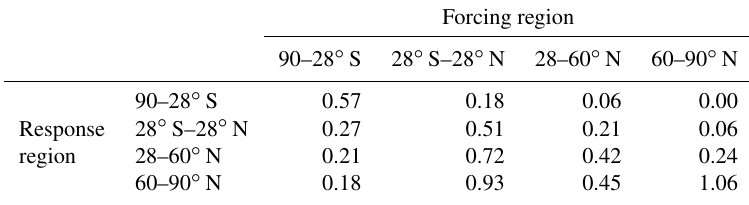
Table B2. Regional climate sensitivity coefficients employed in Eq. (B1) for radiative forcing due to BC in snow (K(Wm − 2 ) − 1 ).